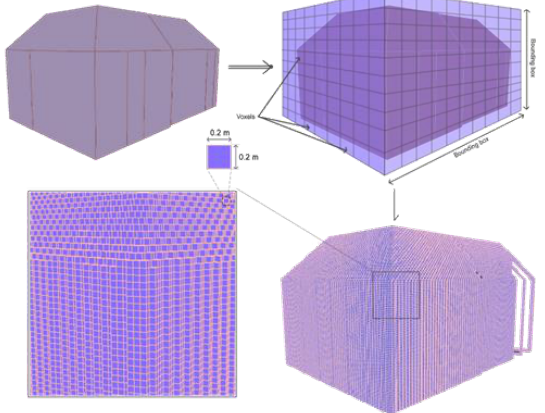
Figure 6 Voxelisation of GML models in PostGIS into Voxels.